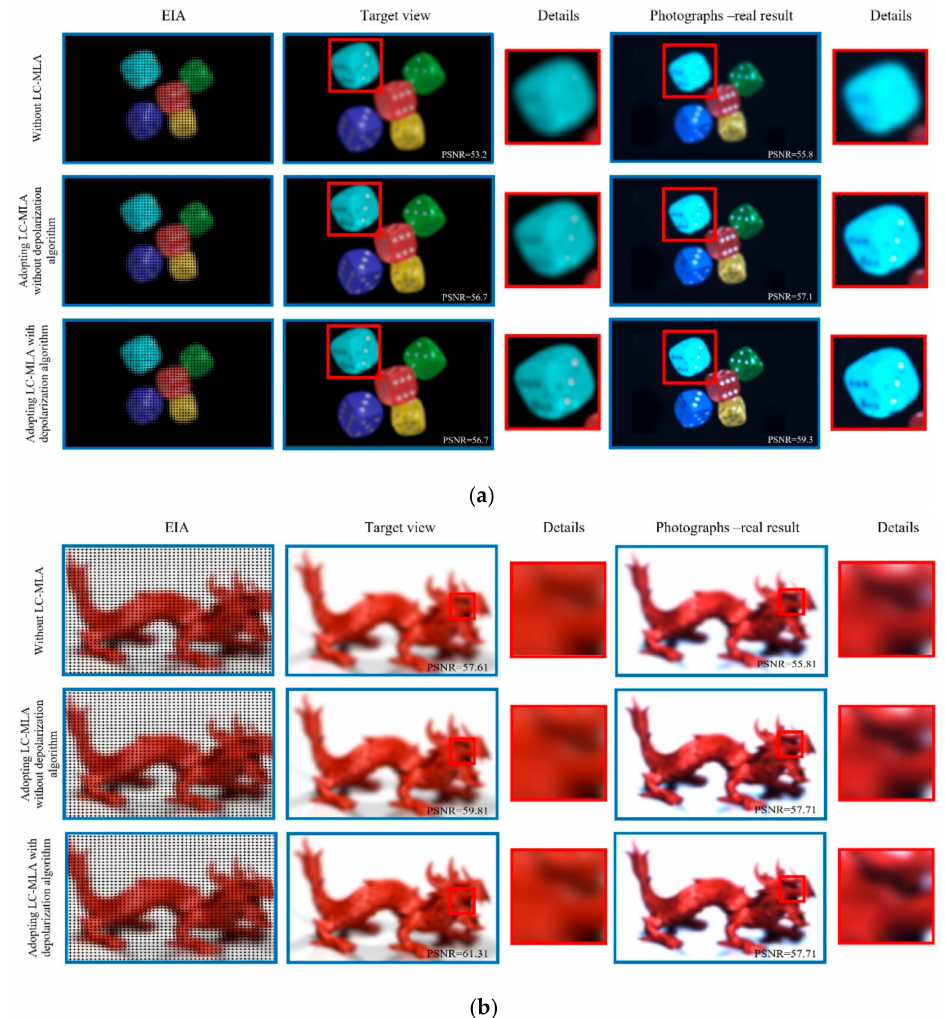
Figure 5. Comparative experiment intermediate results of light field display on the smartphone. ( a ) The “Dices”; ( b ) The